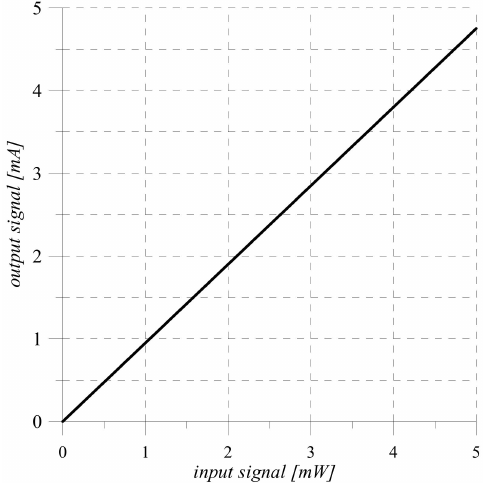
Figure 2. Static characteristic of the